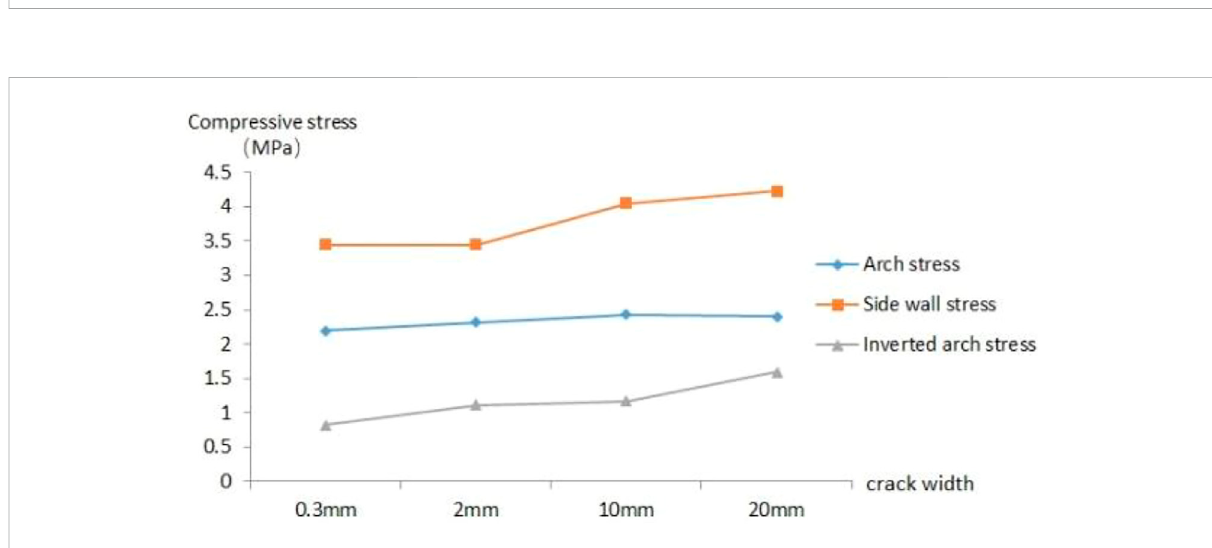
FIGURE 9 Stress variation diagram of main position of arch shoulder cracked lining